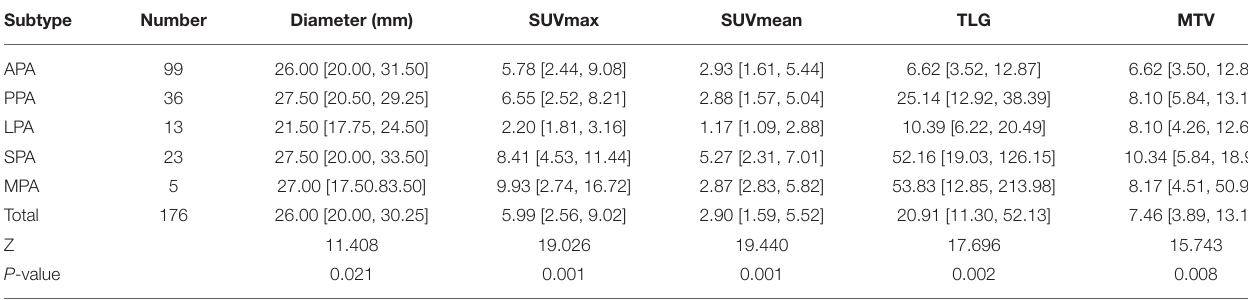
TABLE 3 | The comparison of size and metabolic parameters of lung adenocarcinoma with different pathological subtypes. Subtype